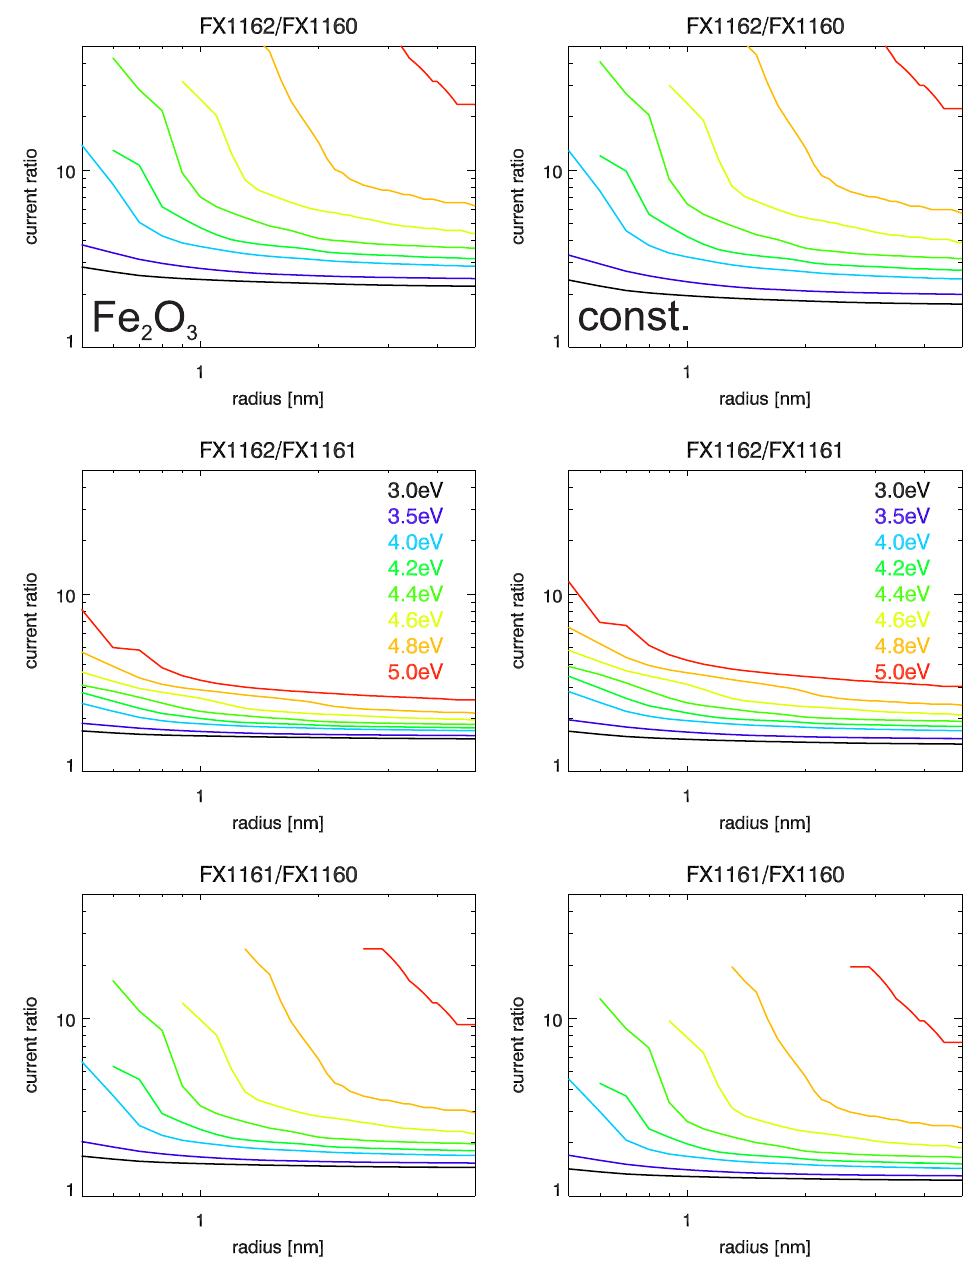
Fig. 9. Calculated photoelectron current ratios for two different assumptions for the photoemission cross-section (i.e., left panels and right panels) and for different combinations of flash lamp types (see title over each panel). In each panel different coloured lines are for different assumed bulk work functions (see insert in middle row panels for colour